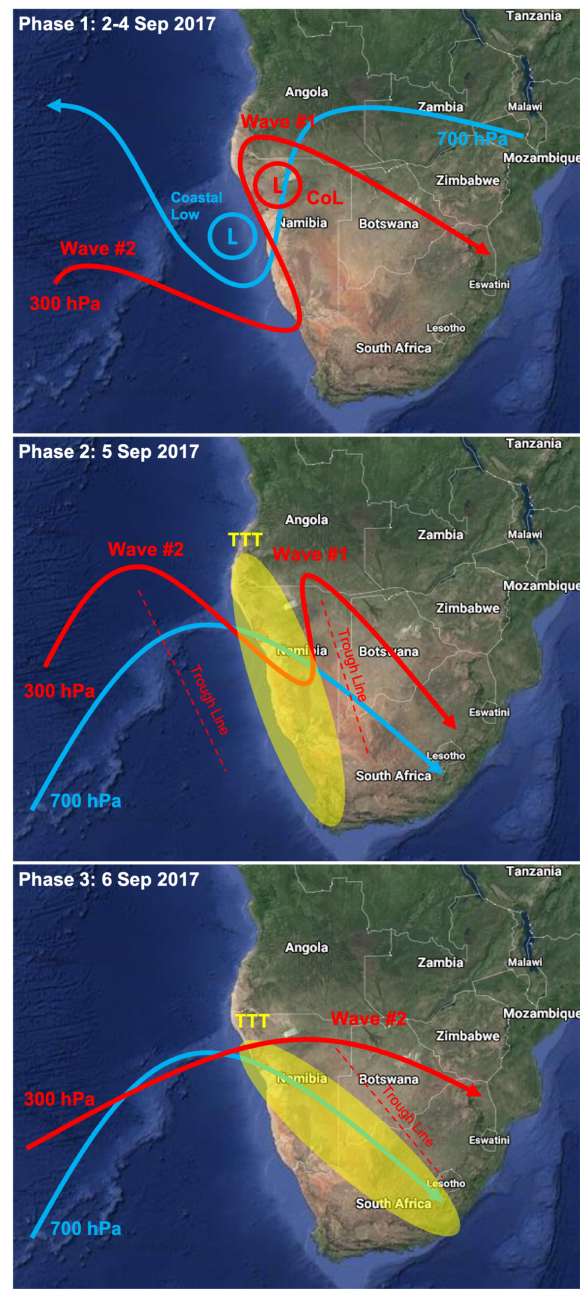
Figure 15. Map of southern Africa with the main dynamical fea- tures described in the text during the period 2–6 September 2017. (a) Phase 1 (2–4 September) with the easterly flow at 700hPa (blue line with arrow) and the imbedded coastal low (blue L), together with the westerly waves at 300hPa (red line with arrow) and the imbedded CoL (red L). (b) Phase 2 (5 September) with the lo- cation of the two westerly waves and associated trough lines (red dashed lines), the westerly mid-level flow at 700hPa (blue line with arrow) and the location of the formed TTT (yellow-shaded area). (c) Phase 3 (6 September) with the passage of the second westerly wave and the associated trough line over the continent and the east- ward displacement of the TTT. Map credit: © Google Earth